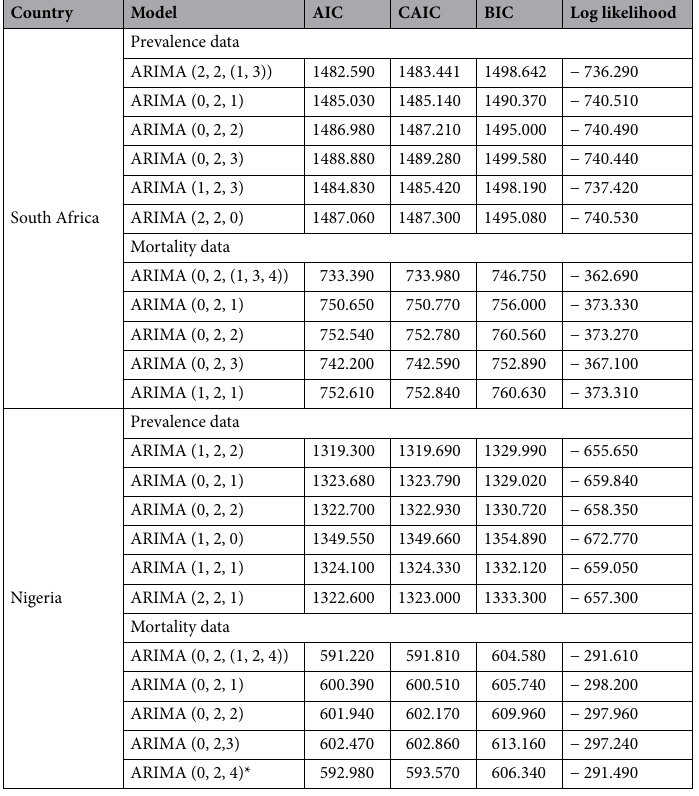
Table 1. The possible tested ARIMA models for the prevalence and mortality time series of COVID-19 in South Africa and Nigeria. ARIMA Autoregressive integrated moving average method, AIC Akaike information criteria, CAIC consistent AIC, BIC Bayesian information criterion. *Represents the parameters were no significantly statistical difference.